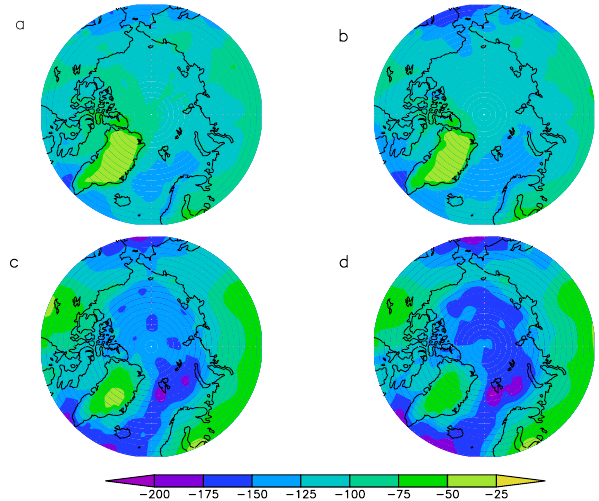
Fig. 14. Summer (JJA) cloud radiative shortwave forcing at the sur- face (W m − 2 ). Left panel ( a and c ) show the pre-industrial condi- tions, right panel ( b and d ) show the mid-Holocene conditions. Up- per row shows results from the HadGEM2-ES ( a and b ) and lower row shows results from the MIROC-ESM ( c and d ). Note that the clouds have a stronger cooling effect at the surface in the MIROC- ESM model.